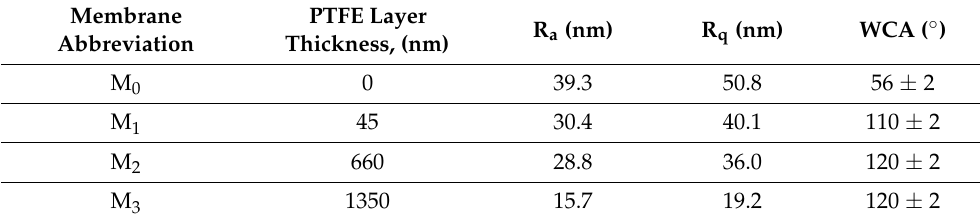
Table 2. Surface roughness parameters and water contact angles of